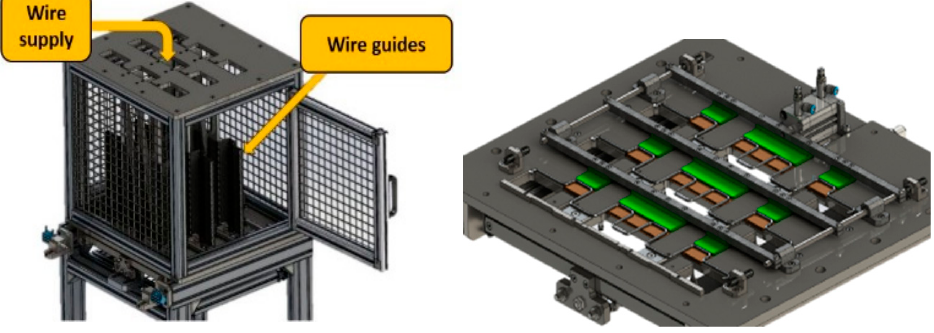
Figure 7. Guide columns and supply system of the wires to the jig in the drawer, respectively. As the storage and feeding system described above will function as an external system to the injection machine, it will be positioned laterally, implying that the gripper that will descend to the drawer and collect the six wires must also be equipped with a rotation movement. Thus, a rotary manipulator needs to be added to the set of devices considered in this project, allowing for the performance of the needed movements in the restricted space available. Due do this space restriction, the rotary manipulator seems to be the best option, because it can be connected to the machine and acts as needed along the lower half-mold, the wires feeding system, and the conveyor belt. In addition, it is intended that each gripper can feed the mold with wires, making its tamping inside the mold, for correct fixing of them inside the mold (they work as inserts), but also being able to extract them after over-injection of plastic at its ends. Therefore, a rotary manipulator was designed, which, through rotation, can switch between three different positions: (a) collect the wires in the drawer, (b) feed the wires and wedge them inside the lower half-mold, and (c) extract the over-injected wires and deposit them on a conveyor belt placed on the same or opposite side of the machine, as can be seen in Figure 8.